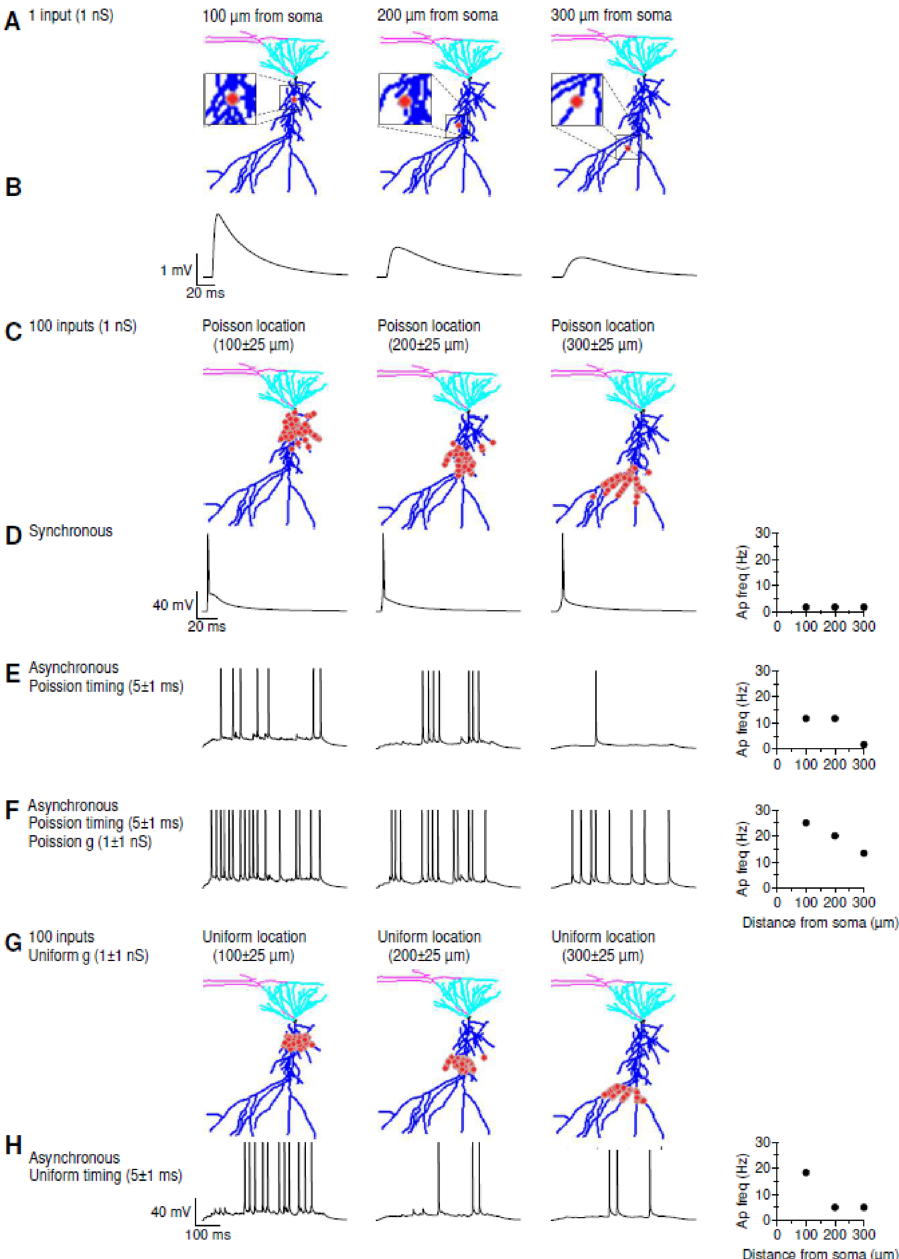
Figure 3. Sample Application of NRN-EZ for summation of supra-threshold EPSPs. ( A ) We used NRN-EZ to place one AMPA excitatory input at 100–300 µm from the soma of a 3D reconstructed, biocytin-filled CA1- PCs. The maximum intensity projection of the CA1-PC includes the soma ( black ), basal dendrites ( cyan ), apical dendrites ( blue ) and the location of the input ( red ). The synaptic weight was set to 1 nS. ( B ) Somatic recording obtained using the NEURON simulation environment. The action potential frequency recorded at the soma for inputs located at increasing distances is plotted in the right panel. ( C ) As in A, for 100 inputs with a Poisson placement along the distal dendrite of the CA1-PC. ( D ) As in B, in response to the synchronous activation of the 100 inputs described in C. ( E ) Somatic membrane potential recorded in response to the asynchronous activation of the 100 excitatory inputs described in C. ( F ) As in E, for synaptic inputs with a Poisson conductance distribution. ( G ) As in C, for 100 inputs with a uniform spatial distribution centered 100–300 µm away from the soma. ( H ) As in F, for 100 inputs with uniform spatial distribution and uniform timing of